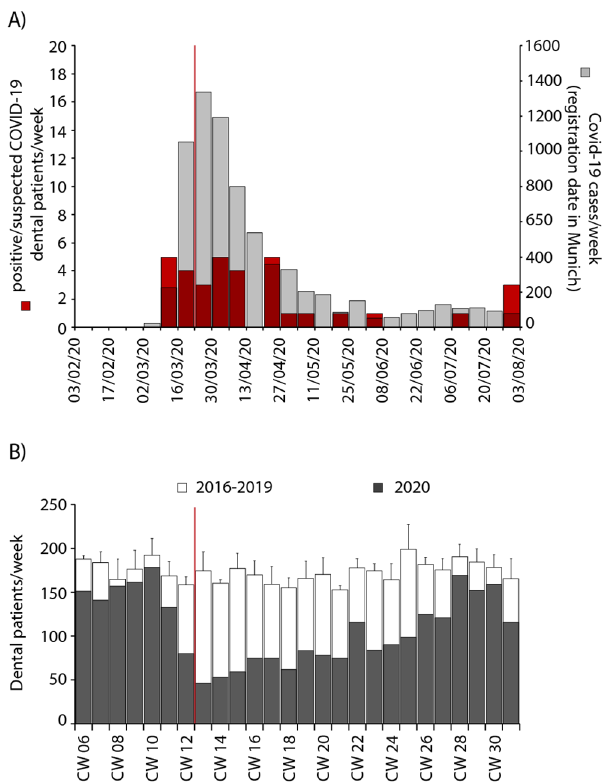
Figure 2. Number of patients with positive/suspected COVID-19 infections concurrent with COVID-19 infections in Munich and comparison of patient numbers with previous years. ( A ) Patients with positive/suspected COVID-19 infections solely in the urgent dental care unit per week (left axis, red) in comparison with officially registered COVID-19 cases in Munich per week (right axis, grey) from 3 February to 31 July 2020. ( B ) Total patient numbers per week compared with patient numbers of the years 2016–2019 in the same calendar weeks (CW, mean ± standard deviation). The red line marks the beginning of the first national lockdown.